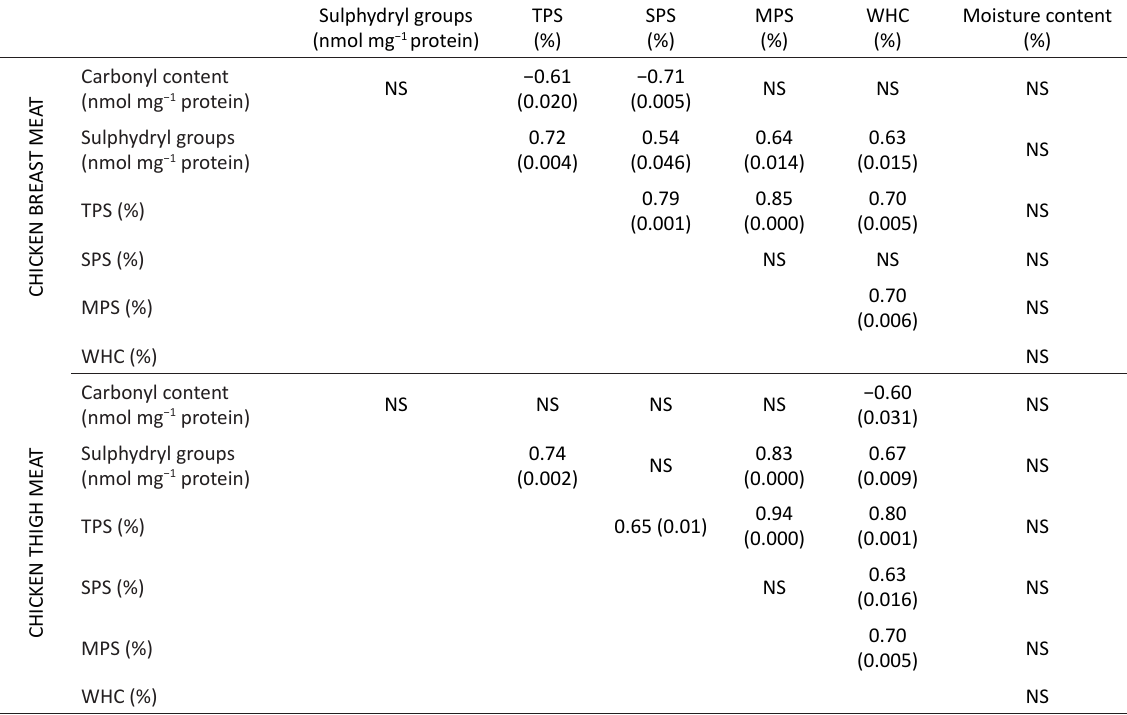
Table 3. Correlation coefficients of quality parameters